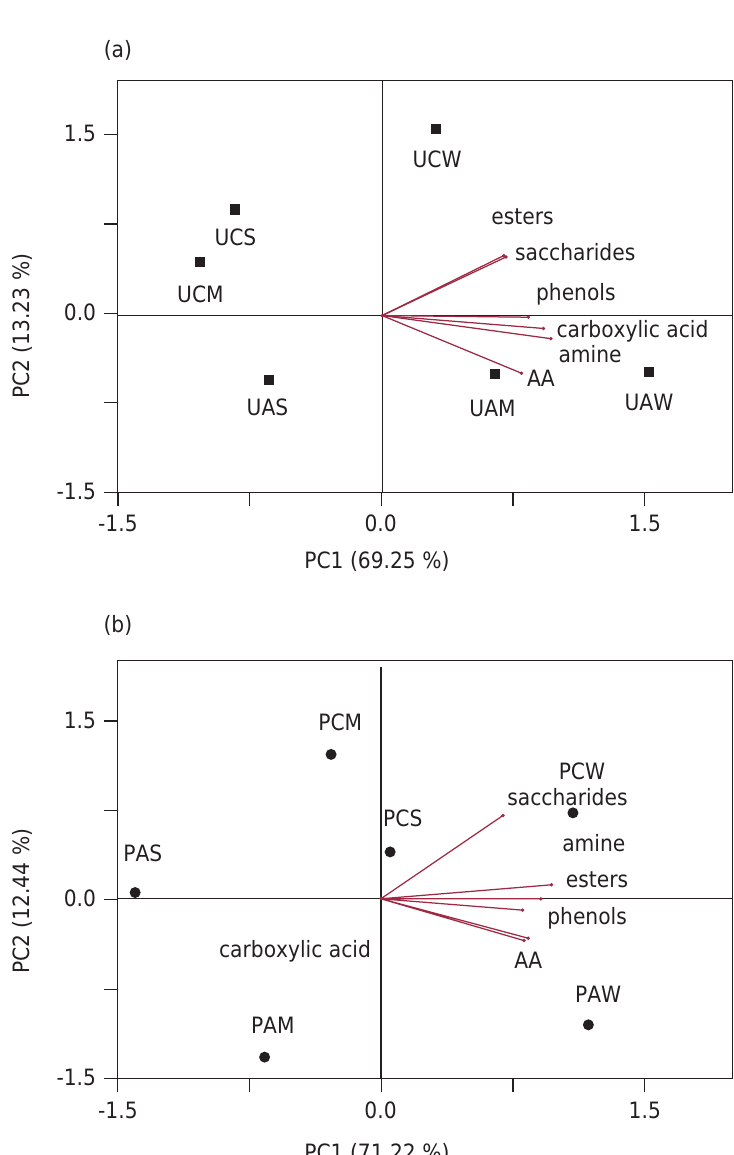
Figure 5. The PCA analysis of average well color development (AWCD) over the soil microbial carbon utilization for soybean (a) and bare (b) soil treatments. UCW: unplanted treatment with elevated CO 2 and well-watered condition; UCM: unplanted treatment with elevated CO 2 and mild drought condition; UCS: unplanted treatment with elevated CO 2 and severe drought condition; PCW: planted treatment with elevated CO 2 and well-watered condition; PCM: planted treatment with elevated CO 2 and mild drought condition; PCS: planted treatment with elevated CO 2 and severe drought condition; UAW: unplanted treatment with ambient CO 2 and well-watered condition; UAM: unplanted treatment with ambient CO 2 and mild drought condition; UAS: unplanted treatment with ambient CO 2 and severe drought condition; PAW: planted treatment with ambient CO 2 and well-watered condition; PAM: planted treatment with ambient CO 2 and mild drought condition; PAS: planted treatment with ambient CO 2 and severe drought